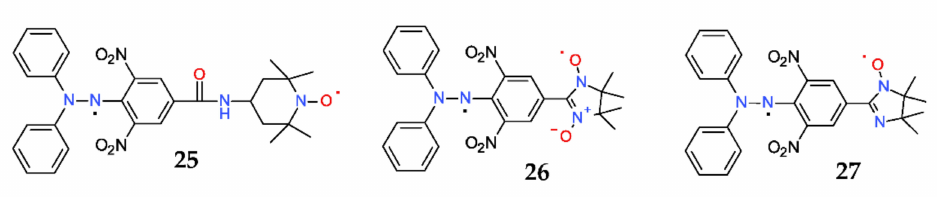
Figure 15. Structure of some